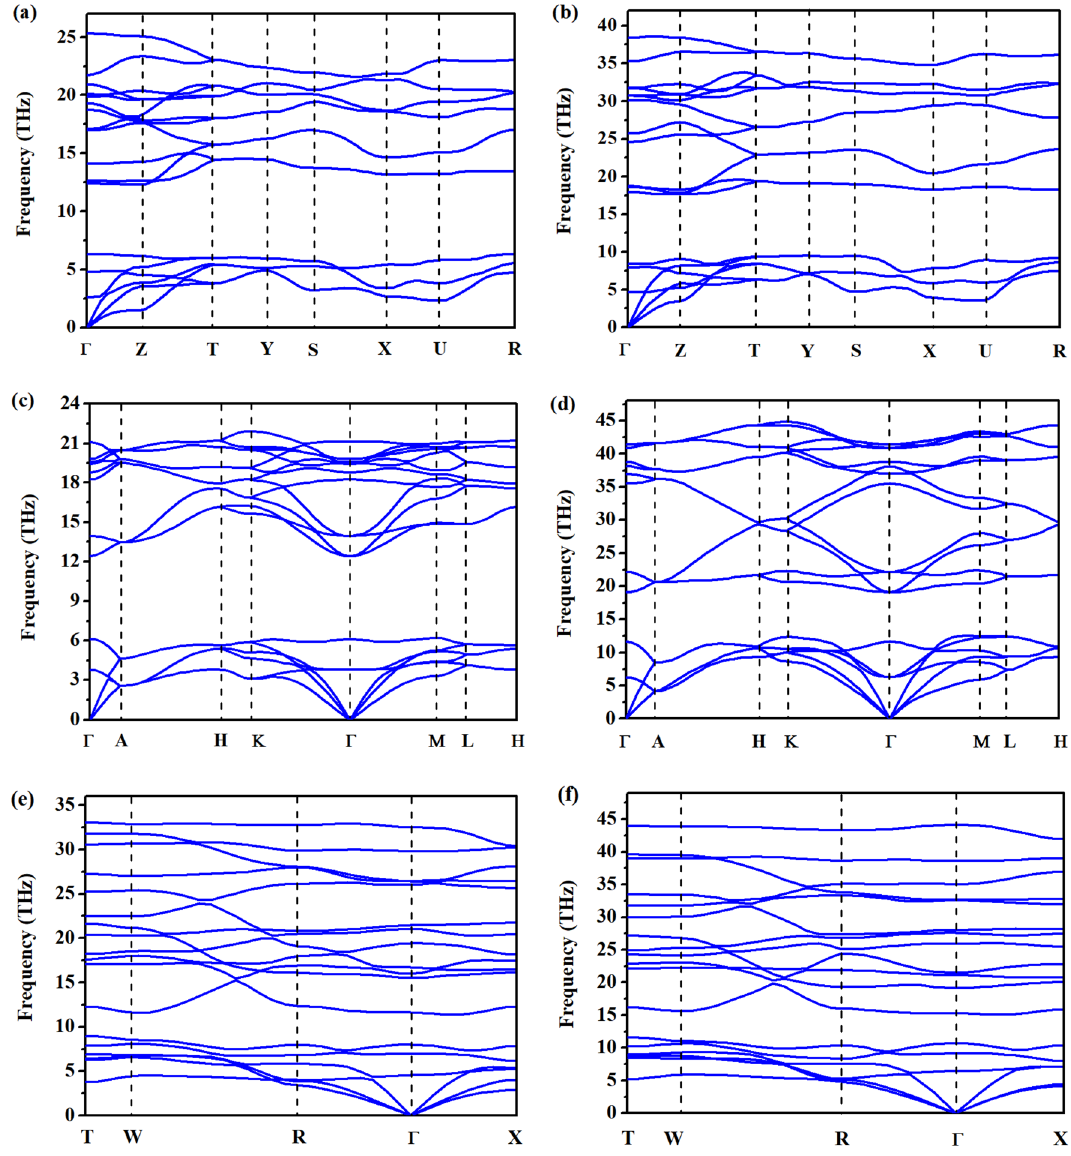
Figure 3. Calculated phonon dispersion curves of ( a , b ) oP 6-OsB 2 at 0 and 200 GPa, ( c , d ) hP 6-OsB 2 at 0 and 440 GPa, and ( e , f ) oI 12-OsB 2 at 200 and 440 GPa,